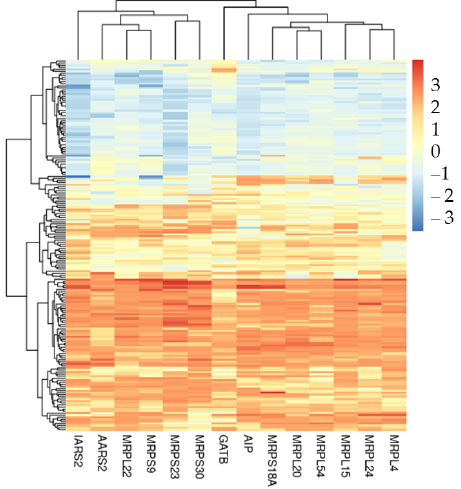
Table 4. DEGs included in the “mitochondrial translation” biological process.